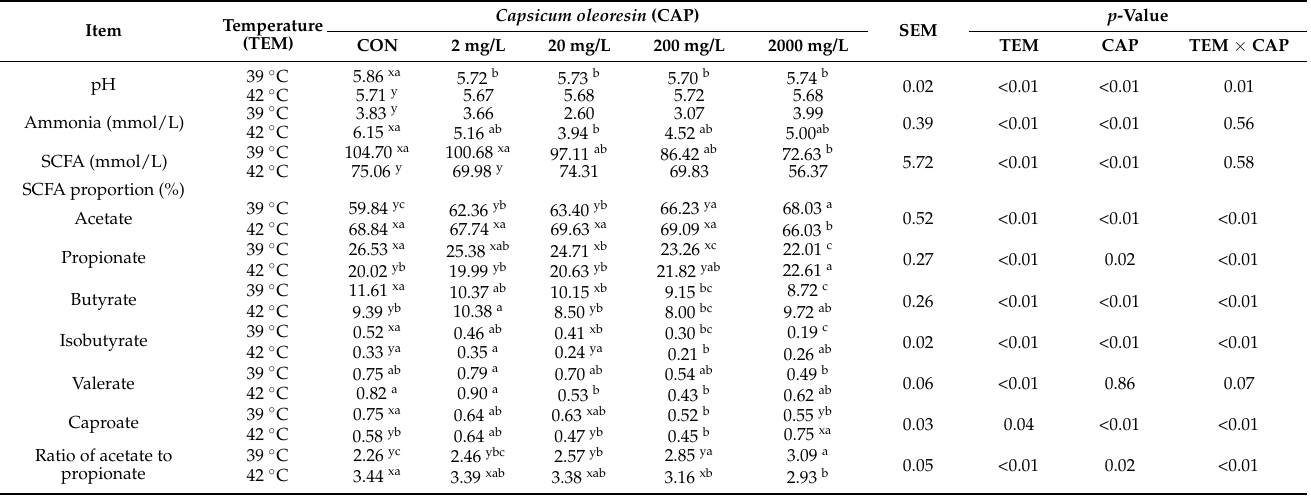
Table 2. Fermentation parameters affected by temperature and Capsicum oleoresin (CAP) supplemen- tation in